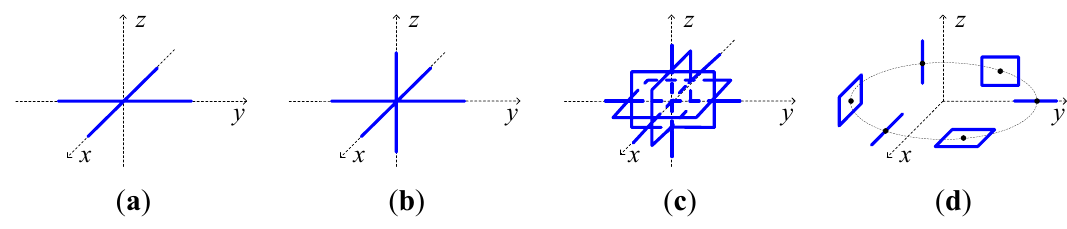
Figure 1. An illustration of four typical EMVS’s. ( a ) Cross-dipole. ( b ) Tripole. ( c ) The cocentered complex EMVS. ( d ) The distributed complete